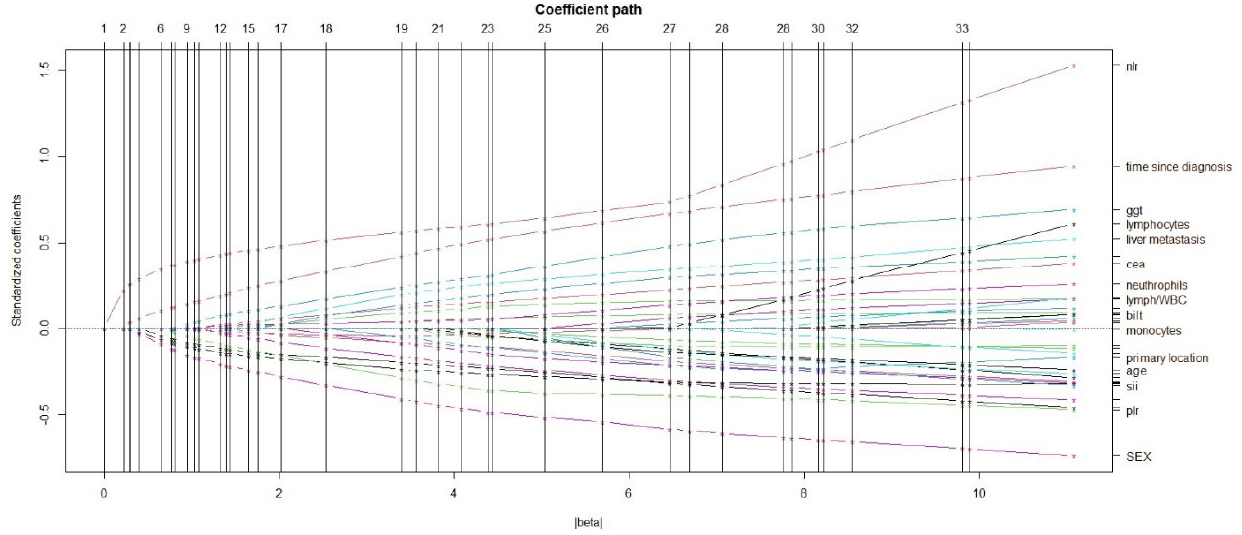
Figure 4. Path of coefficients for a multivariable logistic regression with Least Absolute Shrinkage and Selection Operator (LASSO) analysis of 33 candidate predictors. NLR was identified as the most powerful predictor of vitamin D deficiency.